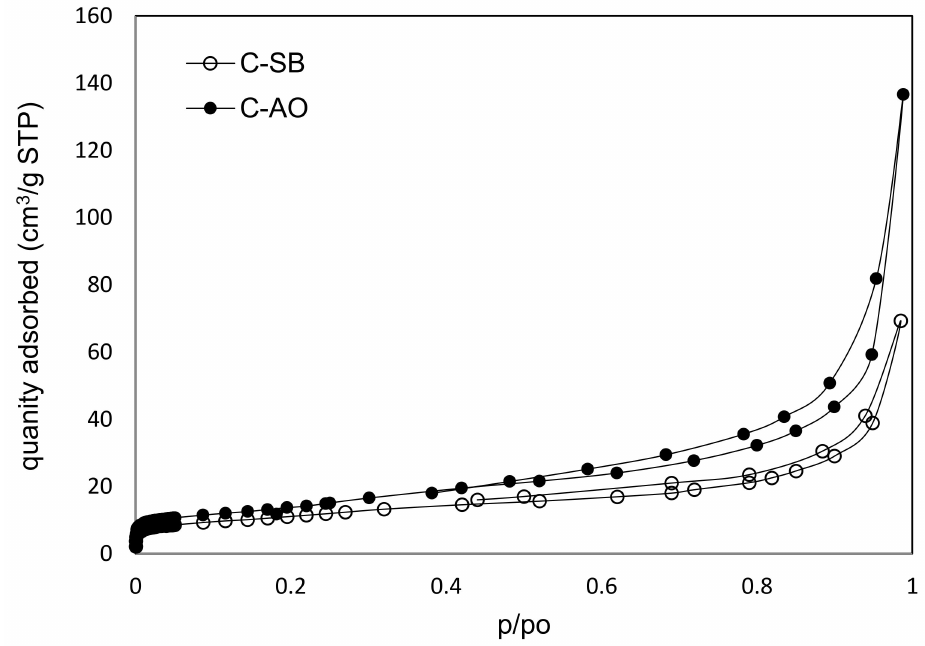
Figure 3. Nitrogen adsorption-desorption isotherms on cleaned carbon materials at 77 K.